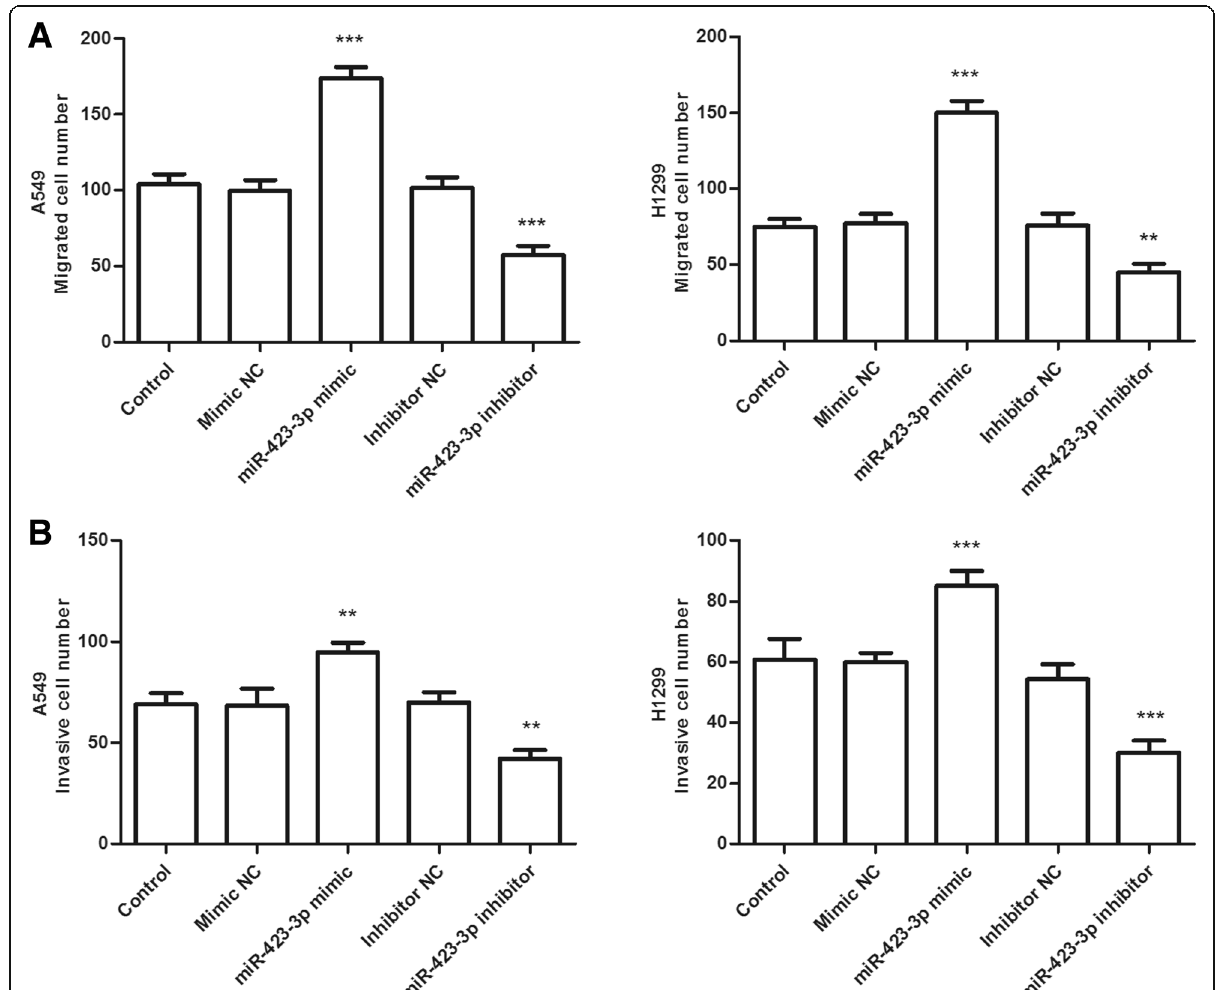
Fig. 4 Overexpression of miR-423-3p promotes cell migration and invasion, while inhibition of miR-423-3p suppresses cell migration and invasion in A549 and H1299 cells. a Effects of miR-423-3p on lung cancer cell migration. (** P < 0.01, *** P < 0.001). b Effects of miR-423-3p on lung cancer invasion. (** P < 0.01, *** P <